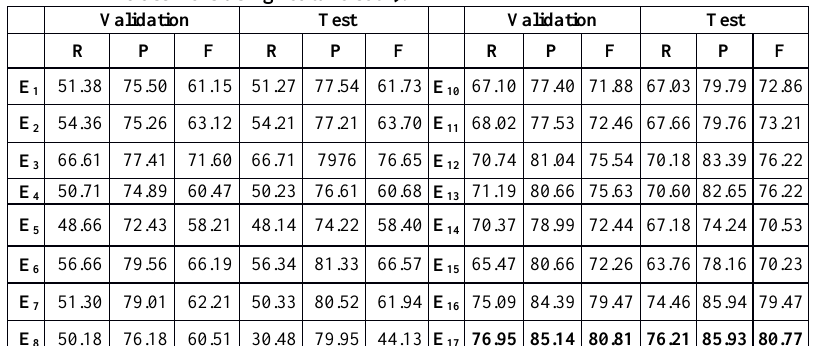
Table 3. Performance of Baseline Classifiers (E i denotes the performance of classifiers using feature set